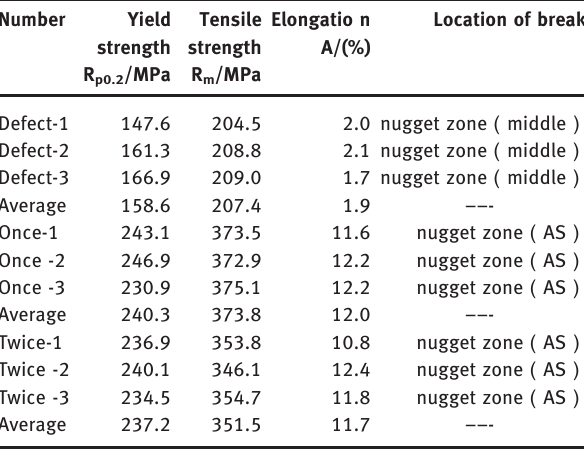
Table 3: Results of repair welding tensile